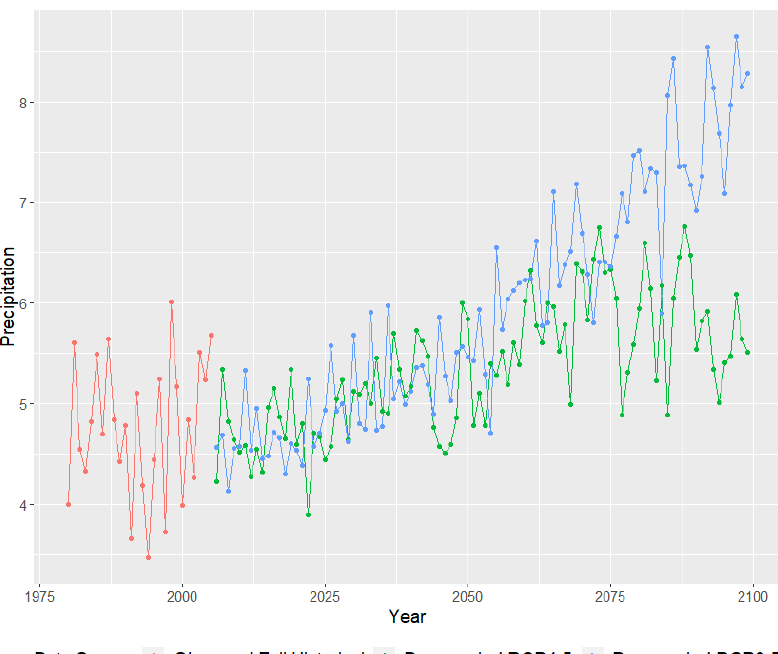
Figure C2. Observed historical (GHCN) daily mean precipitation (mm) is plotted as a function of year (1980–2005) in red. RCP4.5 and RCP8.5 downscaled mean precipitation from 2006–2100 is plotted in green and blue, respectively. This figure was created using Wickham (2016).